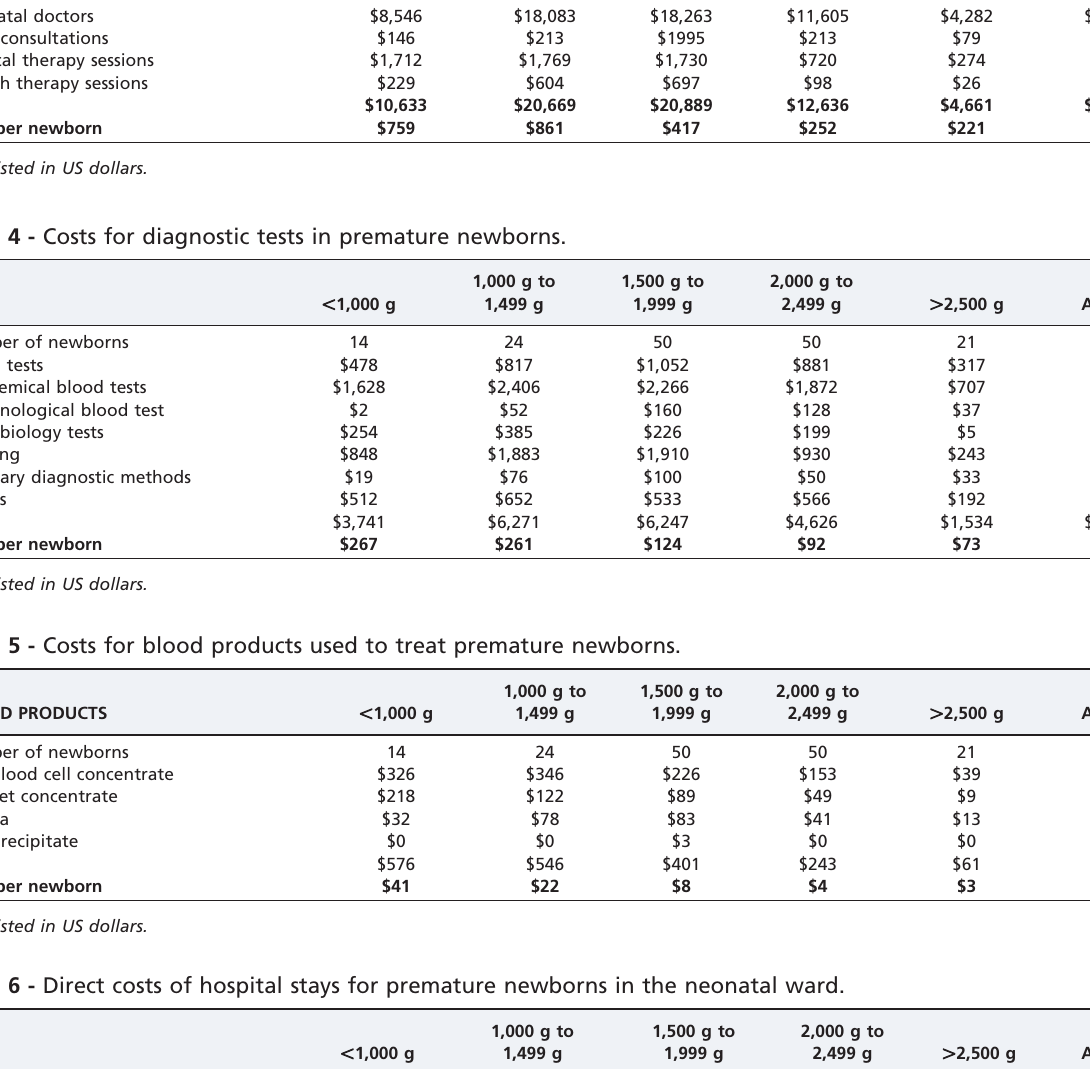
Table 3 - Costs for professional services to treat premature newborns by birth weight. PROFESSIONAL SERVICES Number of newborns